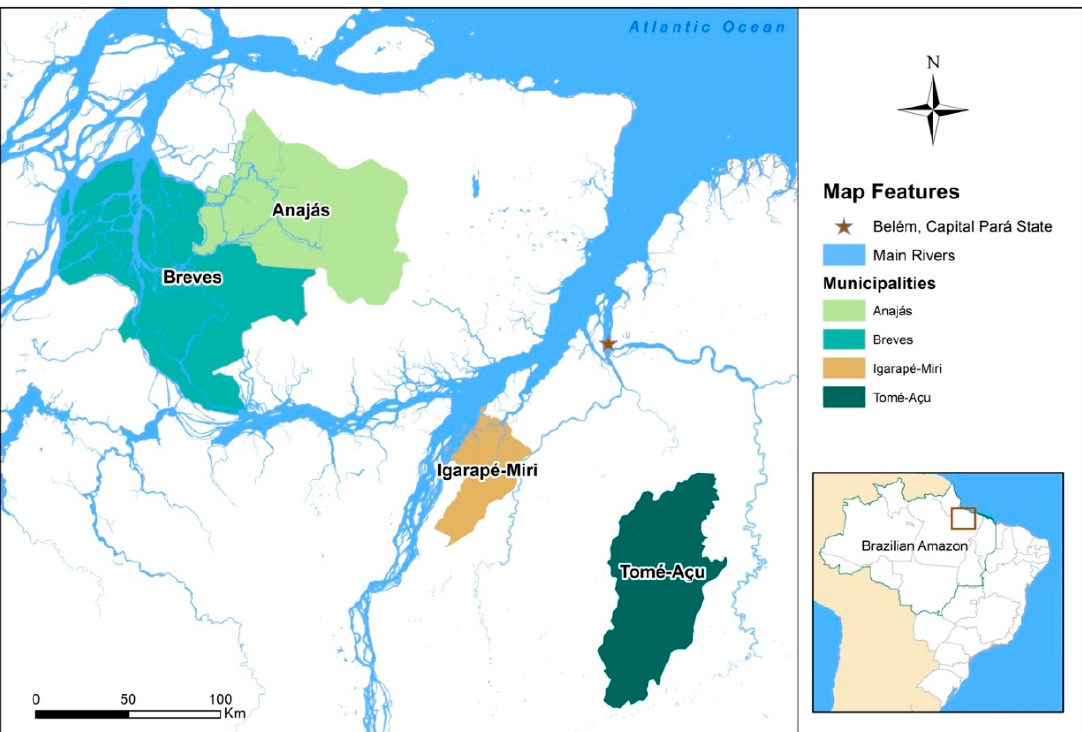
Figure 1. Study region in the northeastern Pará state, Brazilian Amazon.